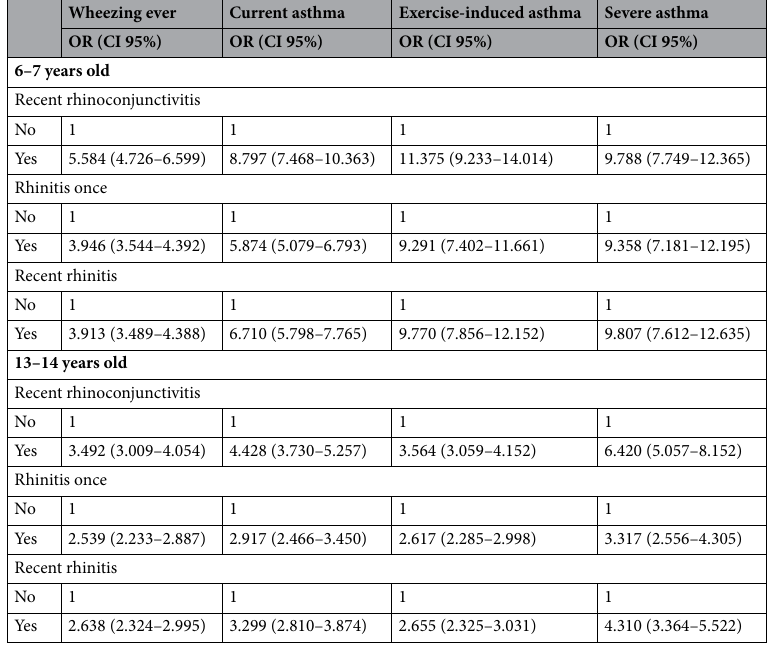
Table 4. Prevalence of asthma symptoms according to rhinitis. Multivariate analysis. OR: Odds Ratio; CI: Confidence Interval; *Recent refers to the previous 12 months. Adjusted by: gender, maternal education, body mass index, parental smoking, cat and dog at